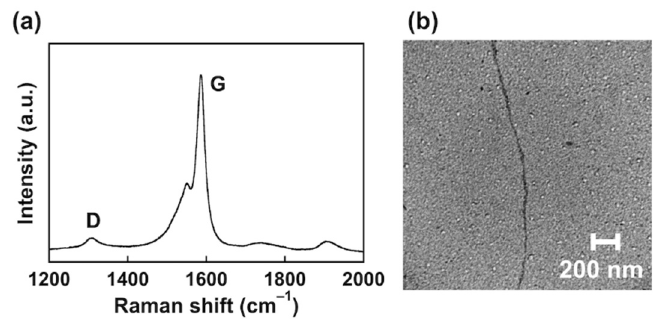
Figure 4. ( a ) Raman spectra of the PC 56 T 44 /SWCNT composite. Excitation wavelength: 633 nm. ( b ) TEM image of the PC 56 T 44 /SWCNT composite.